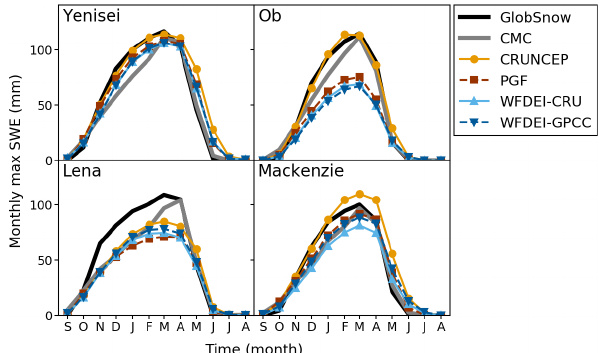
Figure 6. Climatology of monthly maximum SWE (mm) from ob- servations and from the GRC model runs for the common overlap period,